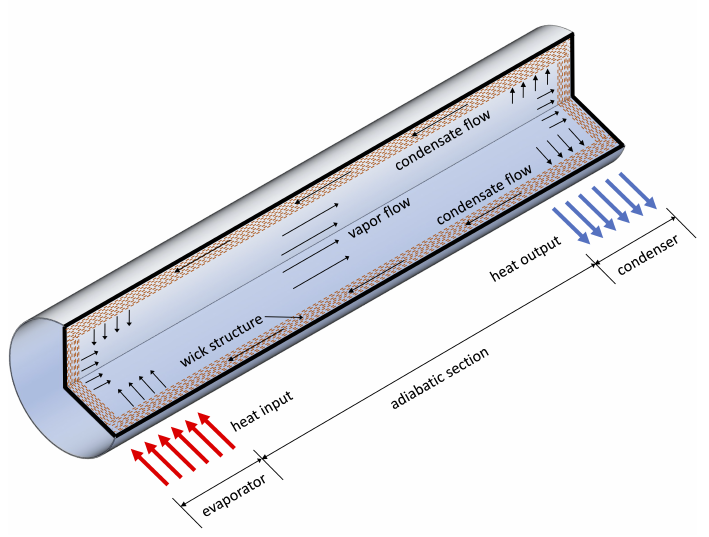
Figure 4. Schematic of conventional heat